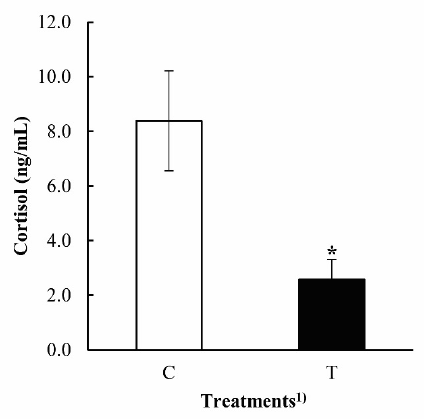
Figure 1. Effect of dietary phytoncide on level of serum cortisol in dairy cow. Values are expressed as mean±standard error of the mean (n = 10), * p<0.05 by Student's t-test. 1 C, control; T, phytoncide